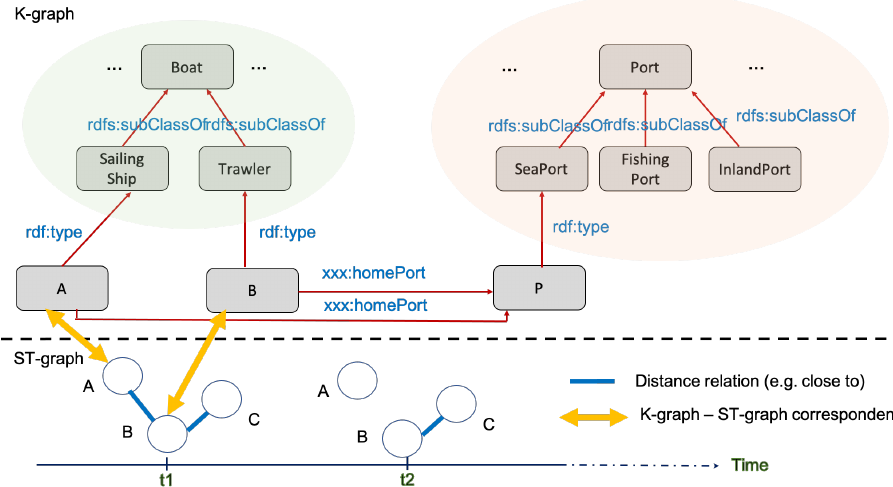
Figure 12. Potential correspondence between K-graph and ST-graph (multiple